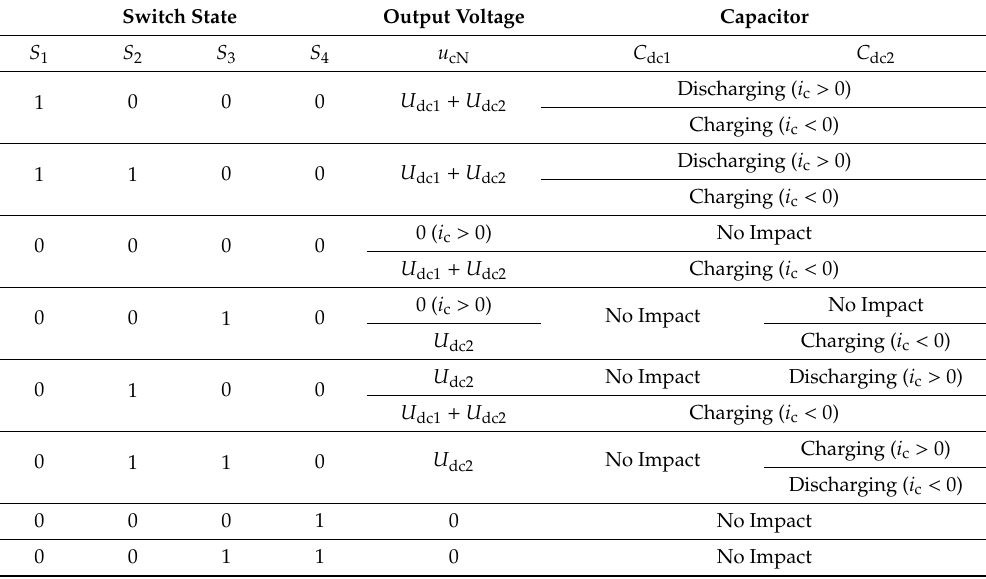
Table 4. Switch states of power router under DC